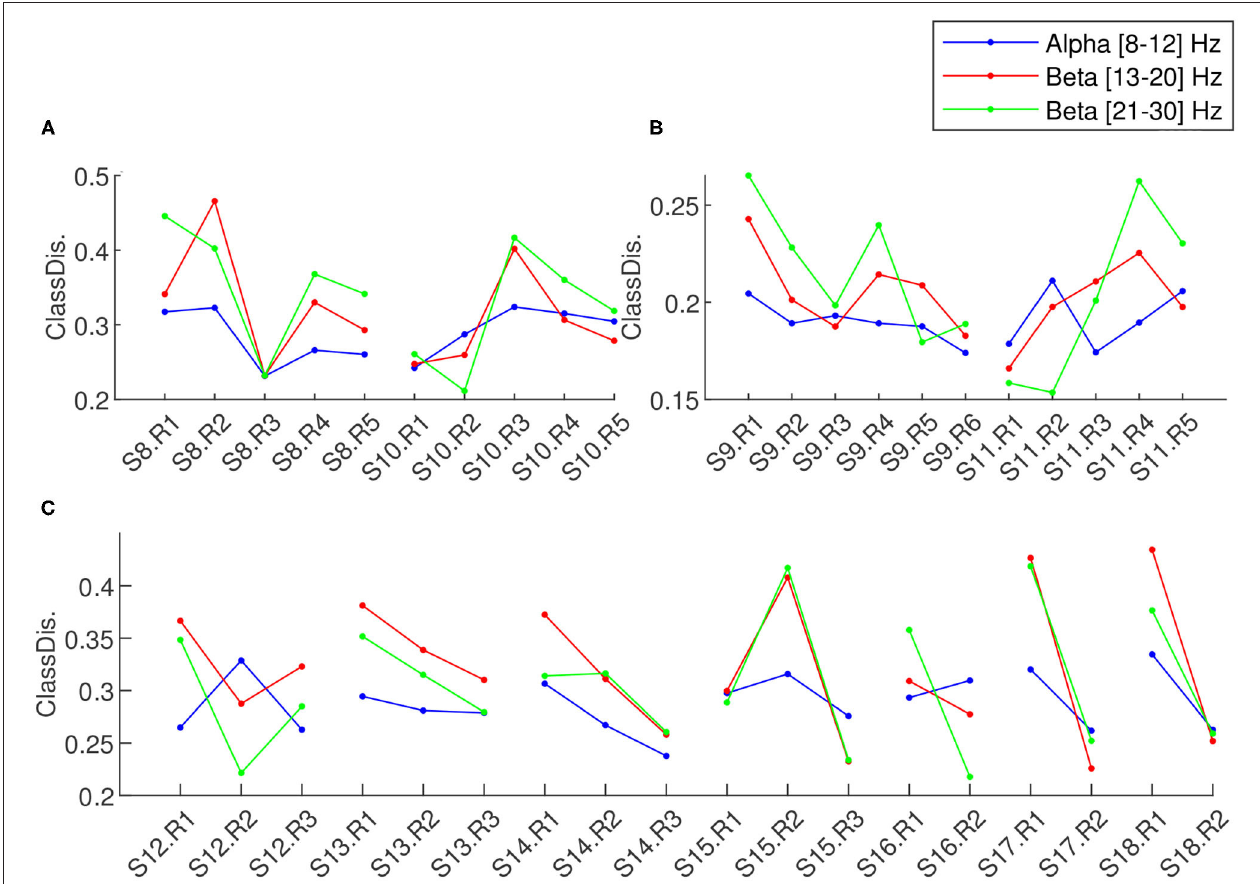
FIGURE 8 | Class discrimination for each run of each session of (A) MENTAL-SUBTRACTION vs. REST of two-class training phase, (B) LEFT-HAND vs. RIGHT-HAND of two-class training, and (C) Transfer phase. Different colors represent different sessions, each point represent a run.